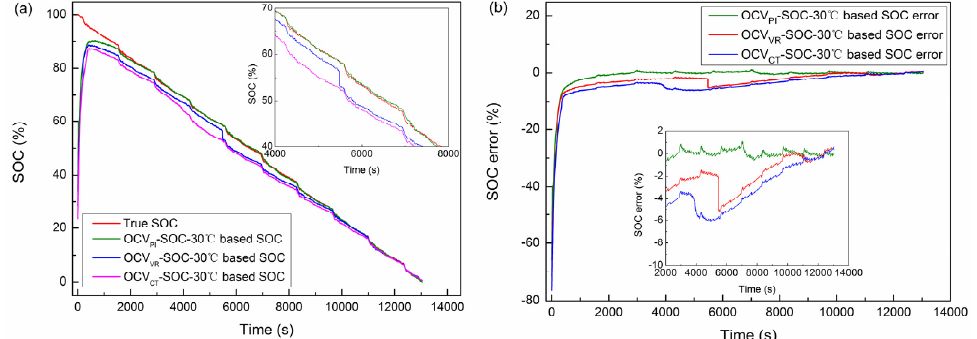
Figure 25. Estimated comparison using the three different OCV–SOC–T relationship maps in the FUDS test at 30 °C: ( a ) SOC and ( b ) SOC